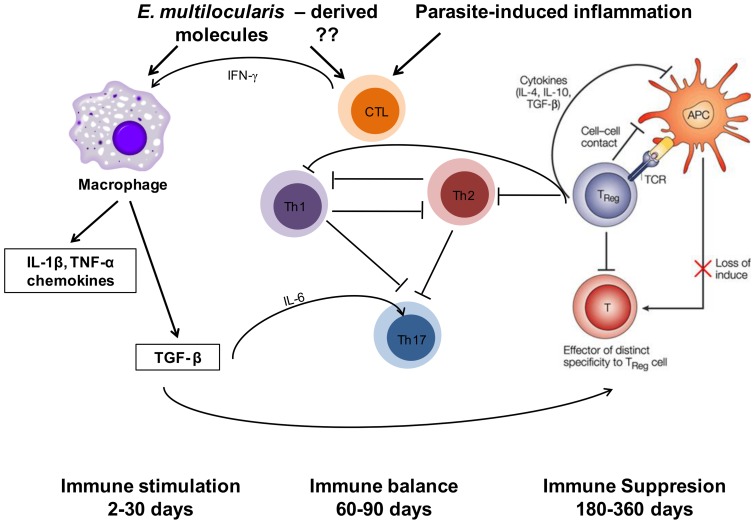
Schematic diagram summarizing the pathways of immune response involved in the host-parasite relationship in E. multilocularis infection.